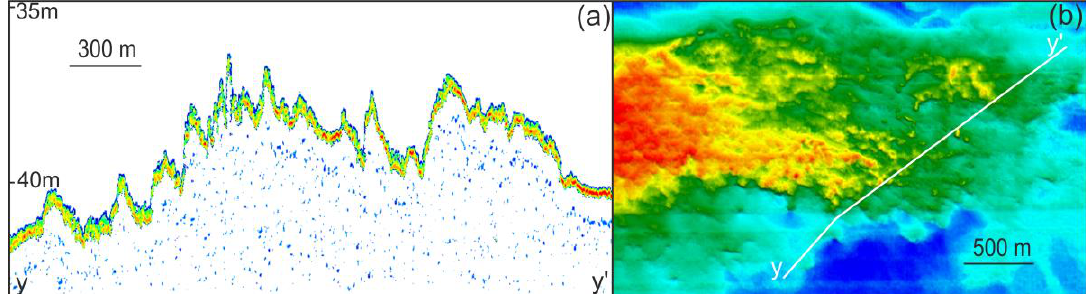
Figure 7. ( a ) Cross-section obtained with the SES-2000 profiler; ( b ) Multibeam bathymetry of the moraine ridges mapped in the north-eastern part of Area 1. The location of the map is shown in Figure 6.